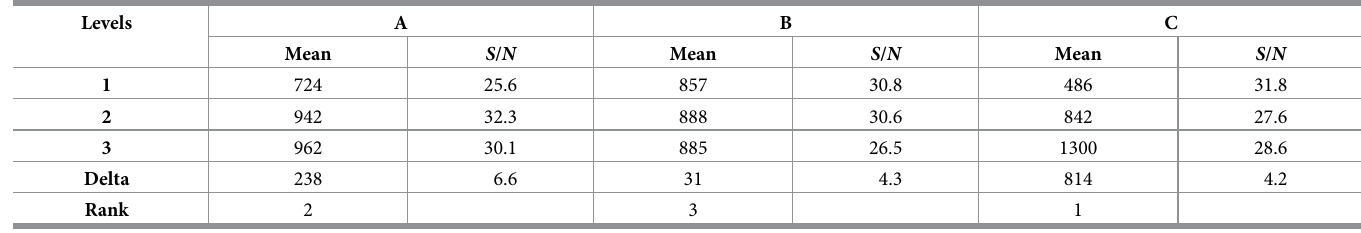
Table 2. Response table for means and S/N ratio.